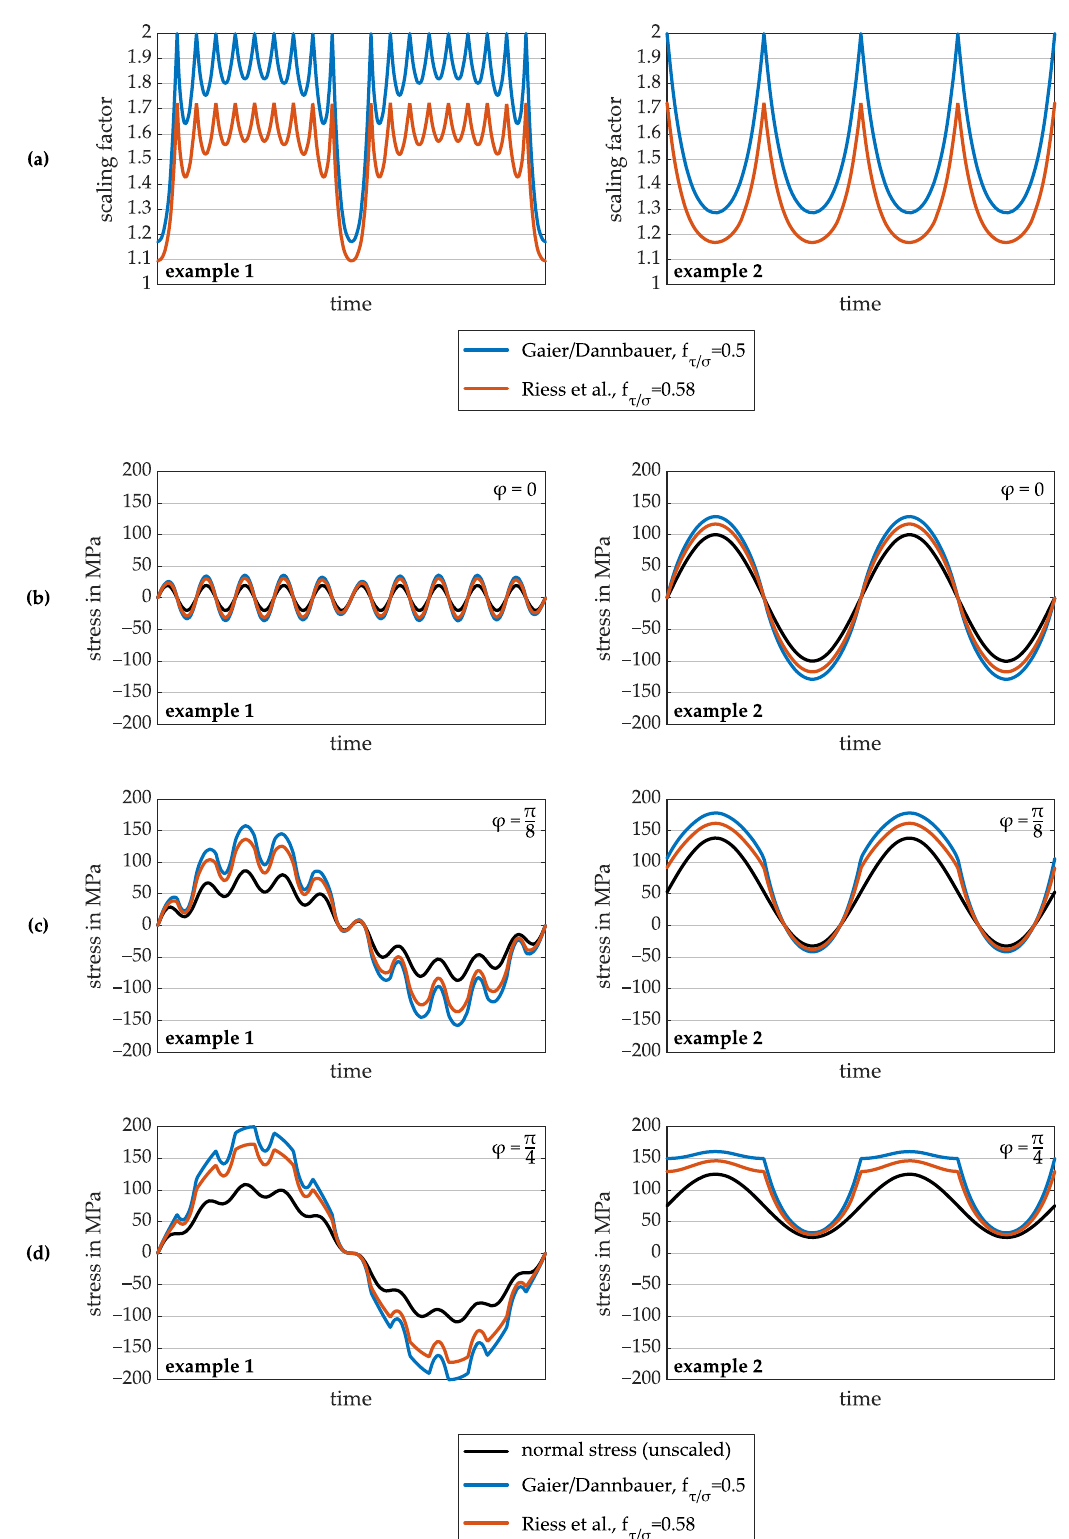
Figure 10. Time series for ( a ) scaling factors and ( b – d ) scaled normal stresses in different planes for the approach according to Gaier–Dannbauer and Riess et al. for the examples 1 and 2 of nonproportional stress series in Figure 5.